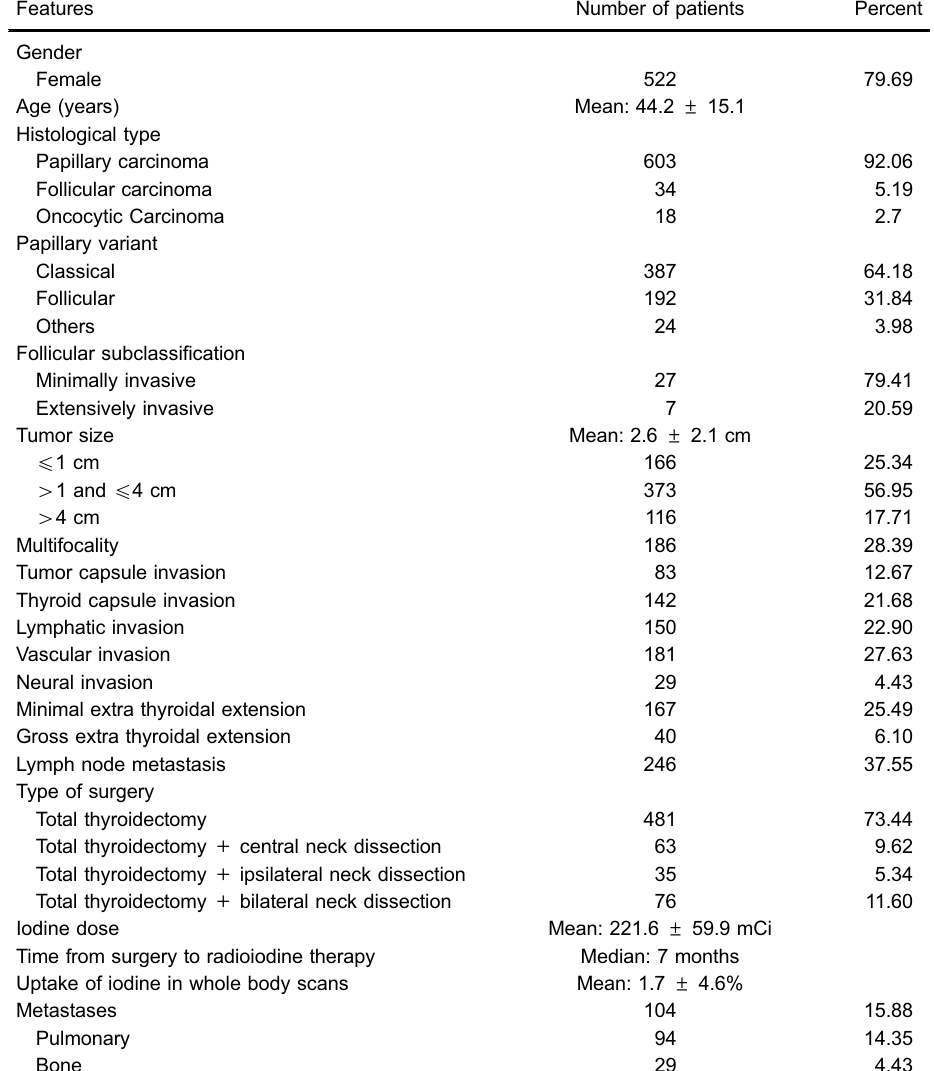
Table 1. Clinical and histopathologic pro fi le of 655 patients with differentiated thyroid cancer.